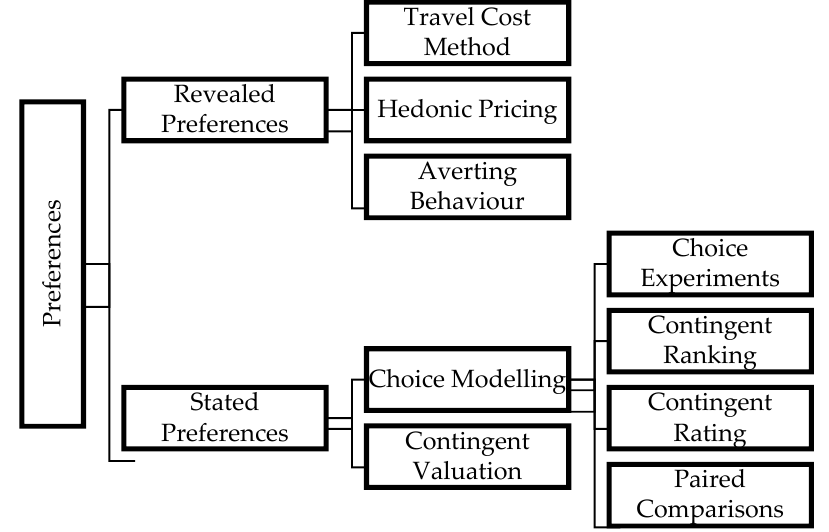
Figure 2. Economic Valuation Methods. Adapted from Garrod and Willis ([79] p. 6), Bateman et al. ([61] p. 30) and Pearce et al. ([59] p. 88).